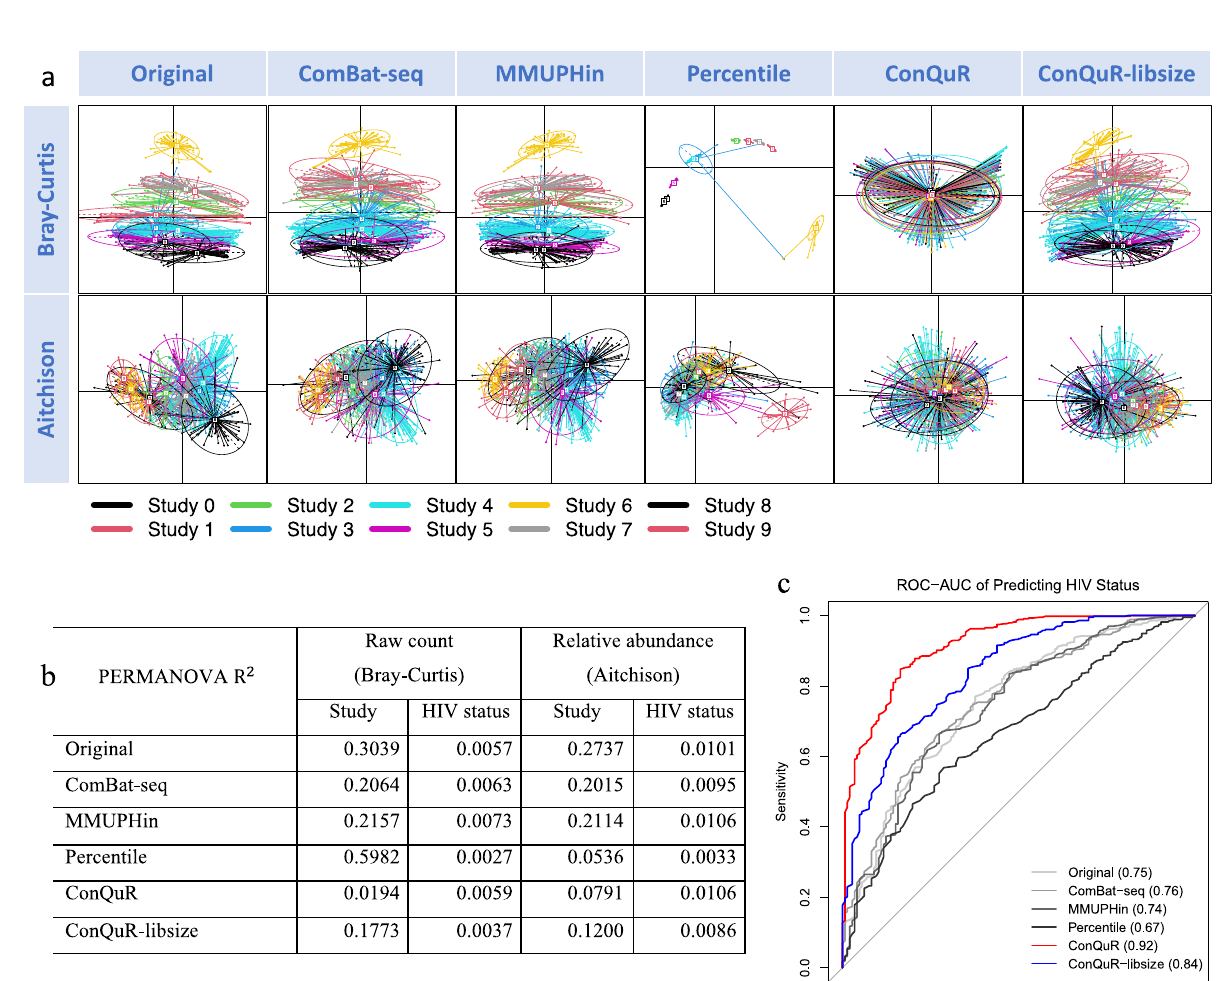
variability explained by batch ID and systolic blood pressure (SBP), quanti fi ed by PERMANOVA R 2 in either Bray-Curtis or Aitchison dissimilarities. Lower variability explained by batch ID with preserved or increased variability explained by SBP is preferred. c Cross-validated root of mean squared error (RMSE) of predicting SBP based on the taxa read counts via random forest, where n =5 folds of cross- validation.LowervaluesindicatestrongerpredictivesignalsofSBPinthemicrobial pro fi les. De fi nitions of the boxplot elements: the center line indicates median, the box limits are upper and lower quartiles, whiskers are the 1.5 interquartile range, and points beyond the whiskers are outliers.